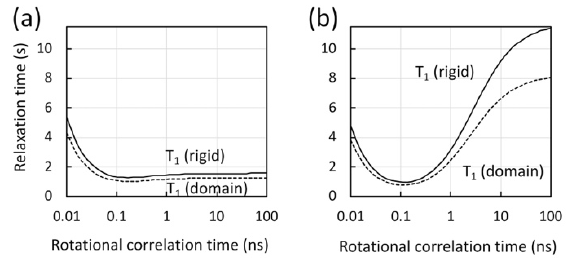
Figure 5. Calculated longitudinal relaxation time (T 1 ) for protons in methyl geometry, ( a ) with and ( b ) without methyl fast rotation, assuming a rigid molecule (solid line) and a molecule with a domain motion at 4 ns (dashed line), as a function of the molecular rotational correlation time at 900 MHz. In the calculations, a model-free spectral density function with an extended fast motion was assumed [140,141] with a generalized order parameter (S s2 ) of 0.8, and with a correlation time for internal motion of 50 ps for a rigid molecule (solid lines) or 4 ns for one that undergoes domain motion (dashed lines). In the calculation in panel ( a ), an order parameter for methyl fast motion (S f2 ) was assumed at 0.25 for methyl protons [117,139]. In the calculation in panel ( b ), S f2 at 0.9 was assumed to provide a relaxation sink .